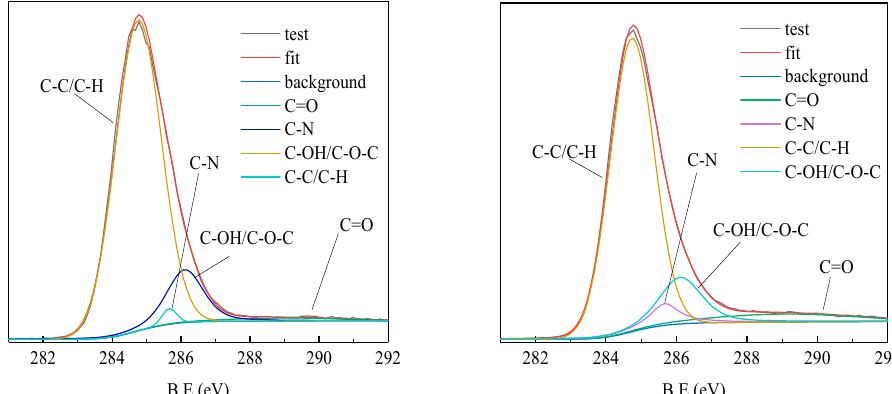
Figure 11. The XPS fitting spectrum of C(1s) in coking coal before adsorption ( left ) and coking coal